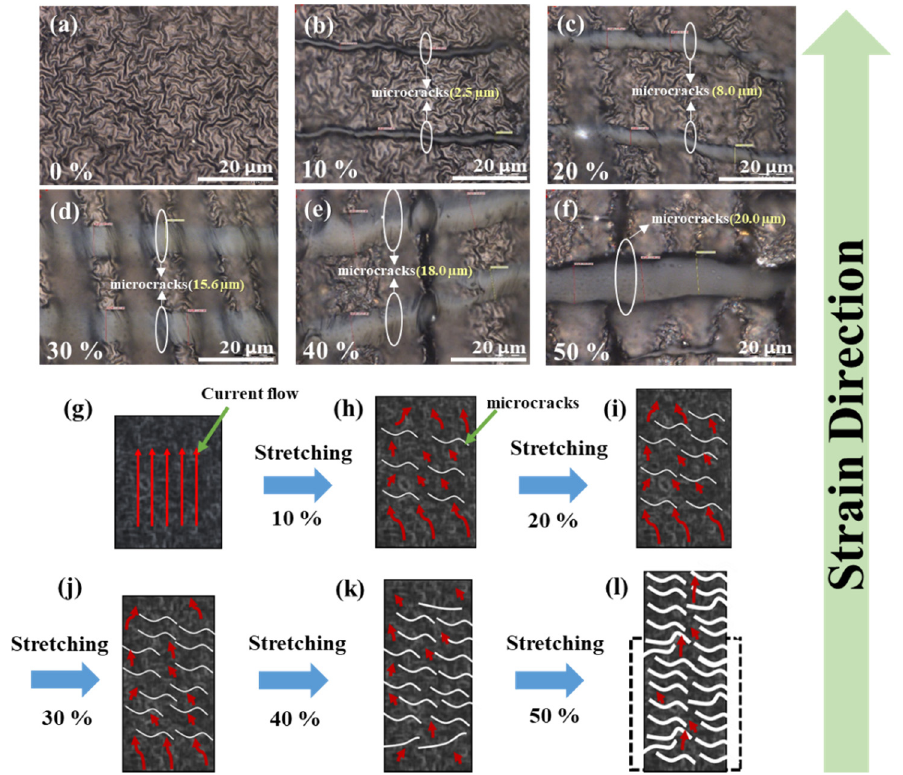
Figure 9. ( a – f ) Microstructural surface evolution of the multi-layer PPys on PDMS (O 2 PT for 30 s) under different tensile strains of 0–50% observed by optical microscopy (×100). ( g – l ) Schematics of the PPy film surfaces under different strains where the currents (red arrow) flow bypassing the open circuit paths generated by microcracks.